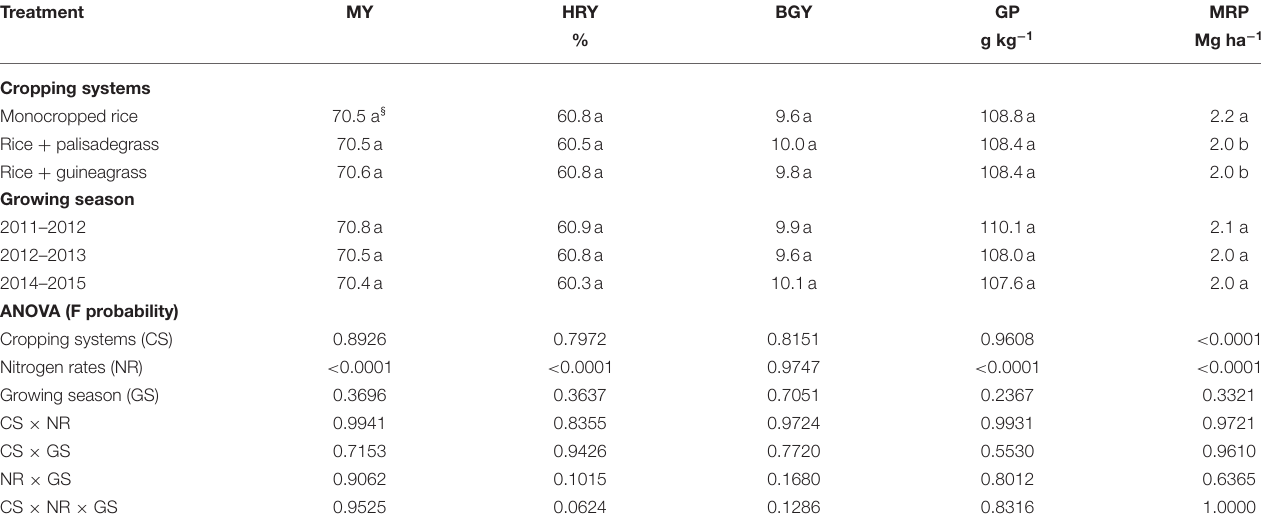
TABLE 2 | Milling yield (MY), head rice yield (HRY), broken-grain yield (BGY), grain protein (GP), and milled rice productivity (MRP) of upland rice as affected by cropping systems, sidedress nitrogen rates, and growing season. Treatment